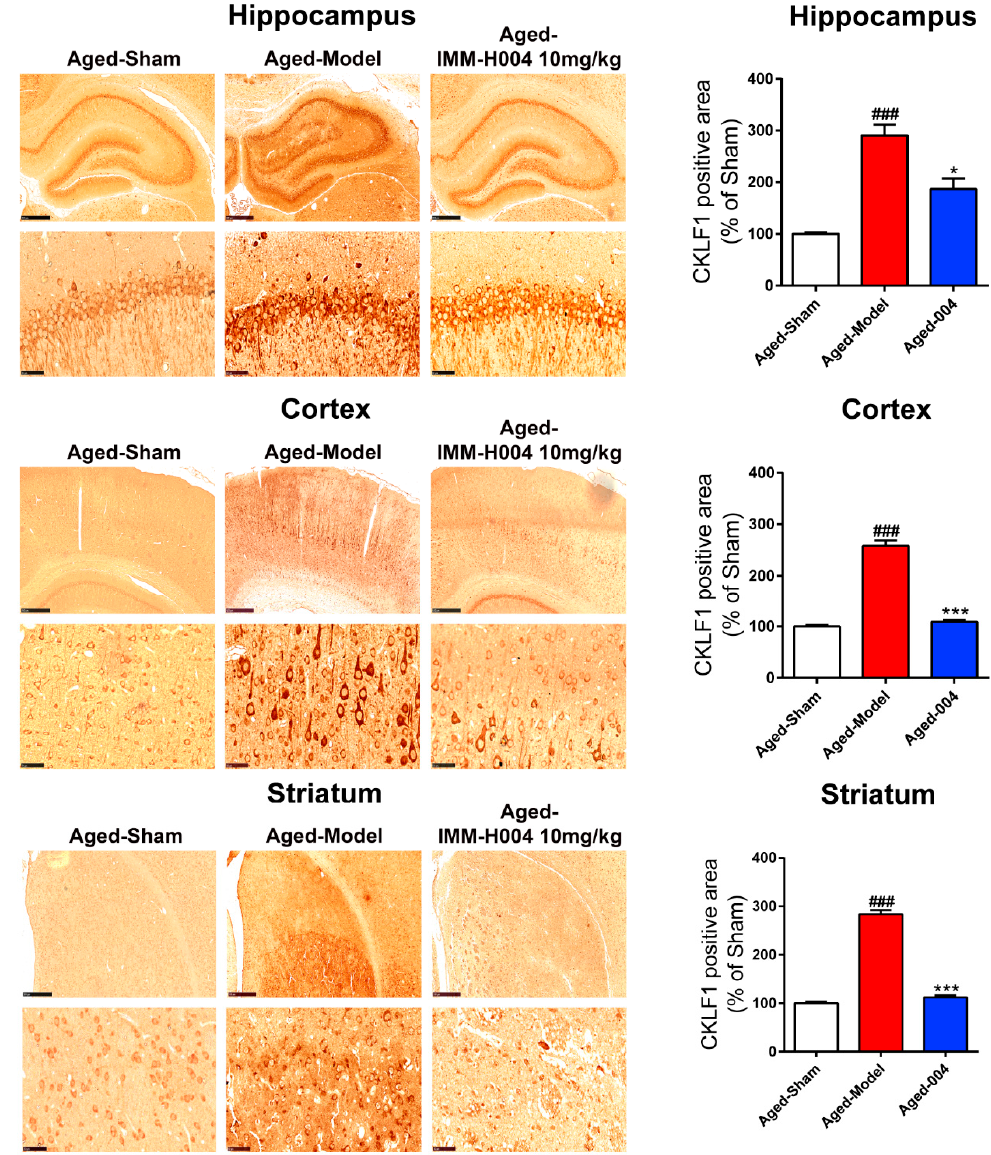
Figure 6. IMM-H004 decreases the expression of CKLF1 in ischemic brain. Expression of CKLF1 in hippocampal CA1, cortex, and striatum subfield from aged rats by immunohistochemical staining (50 × and 400 × magnification, scale bar: 500 and 50 µ m). All the data are shown as the mean ± SD; part of data are shown as the mean ± SD after normalization to the sham ( n = 6/group). ### p < 0.001 vs. sham; * p < 0.05 vs. model; *** p < 0.001 vs. model.